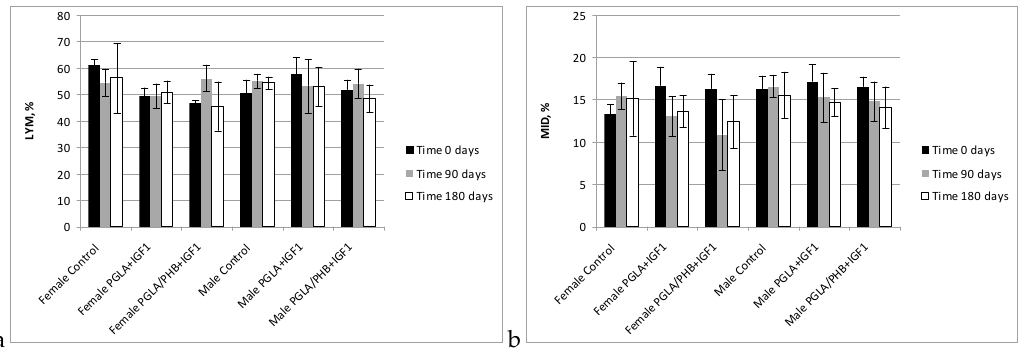
Figure 8. Percentage value of lymphocytes (LYM) ( a ) and other cells (MID) ( b ) in blood of rabbits.